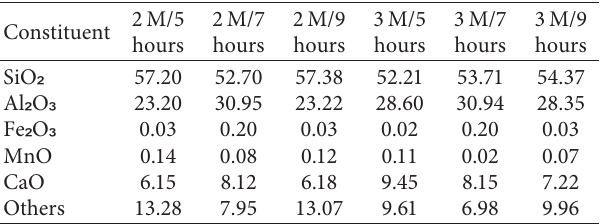
Table 2: Chemical Composition of Synthesized Zeolite Y under varying Conditions.